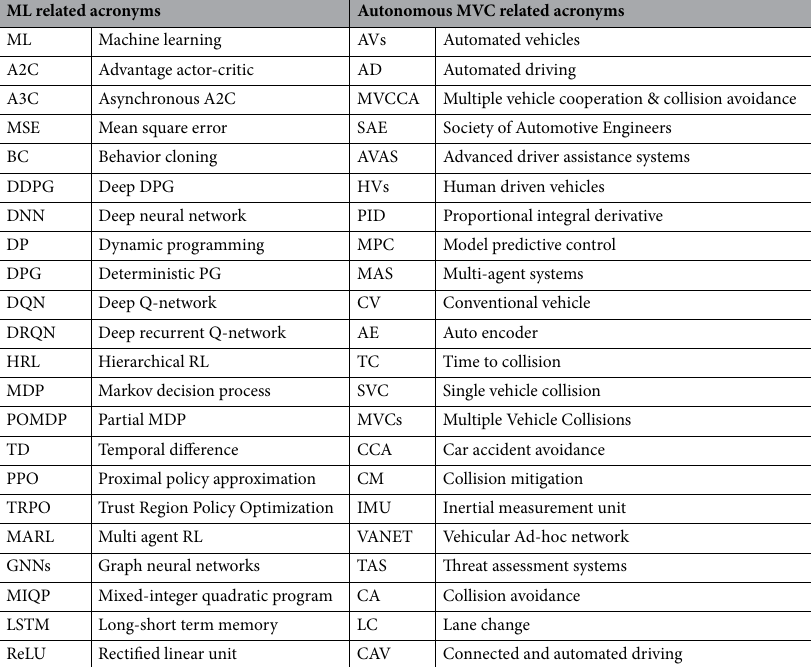
Table 9. Machine learning and automated MVCs related